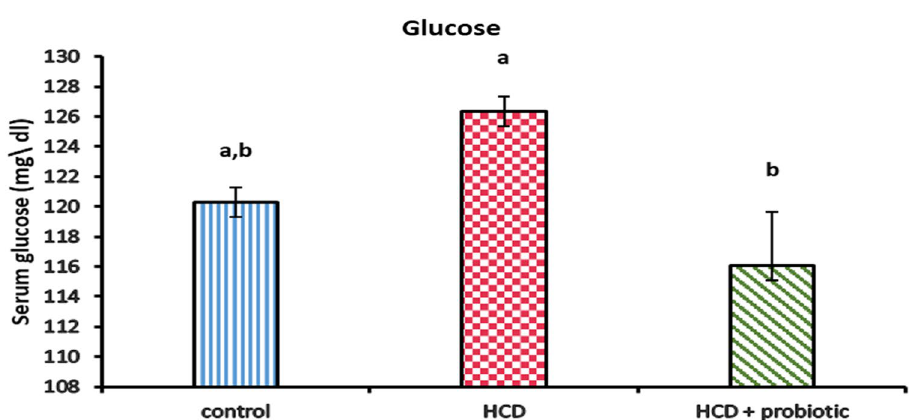
Figure 11. Effect of HCD supplementation and HCD with probiotic on liver function